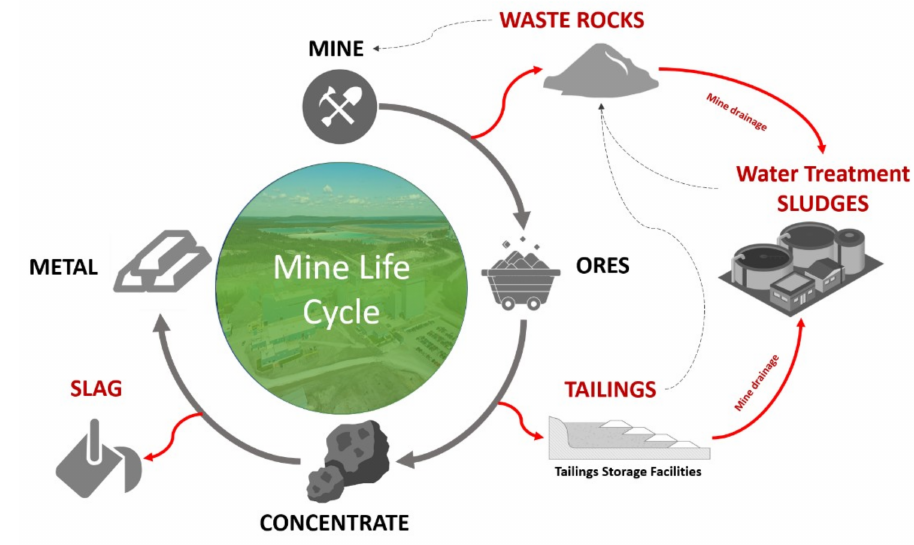
Figure 1. A mine’s life cycle and types of mine